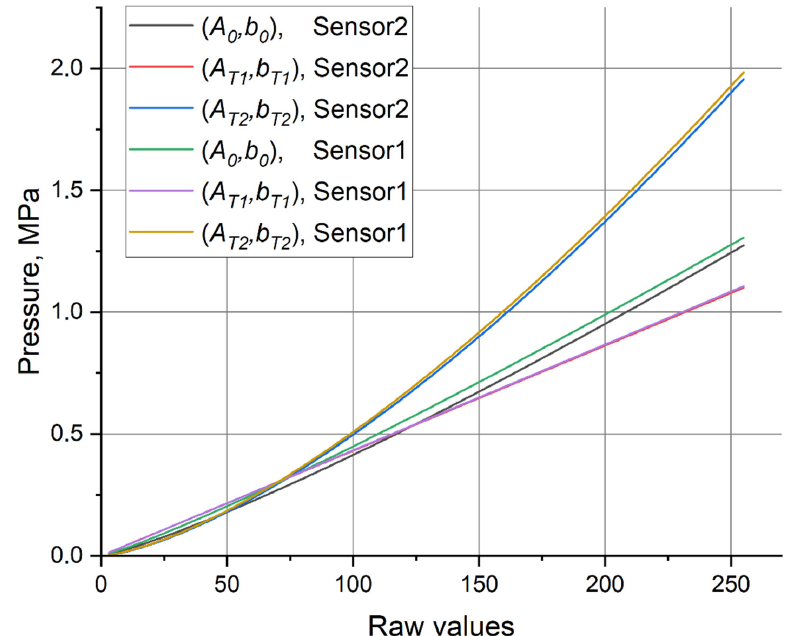
Figure 10. The calibration curves provided by ( A 0 , b 0 ) for Sensor2 (black) and Sensor1 (green) on 18 April 2022 in comparison with the curves provided for these sensors by terminal points T 1 and T 2 from the set { ( A ∗ , b ∗ ) } .